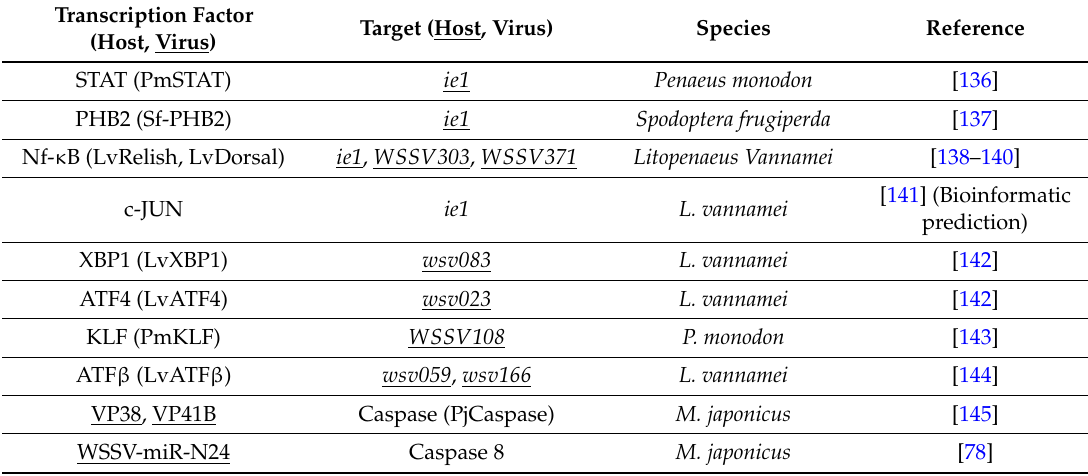
Table 2. Established WSSV–host gene expression